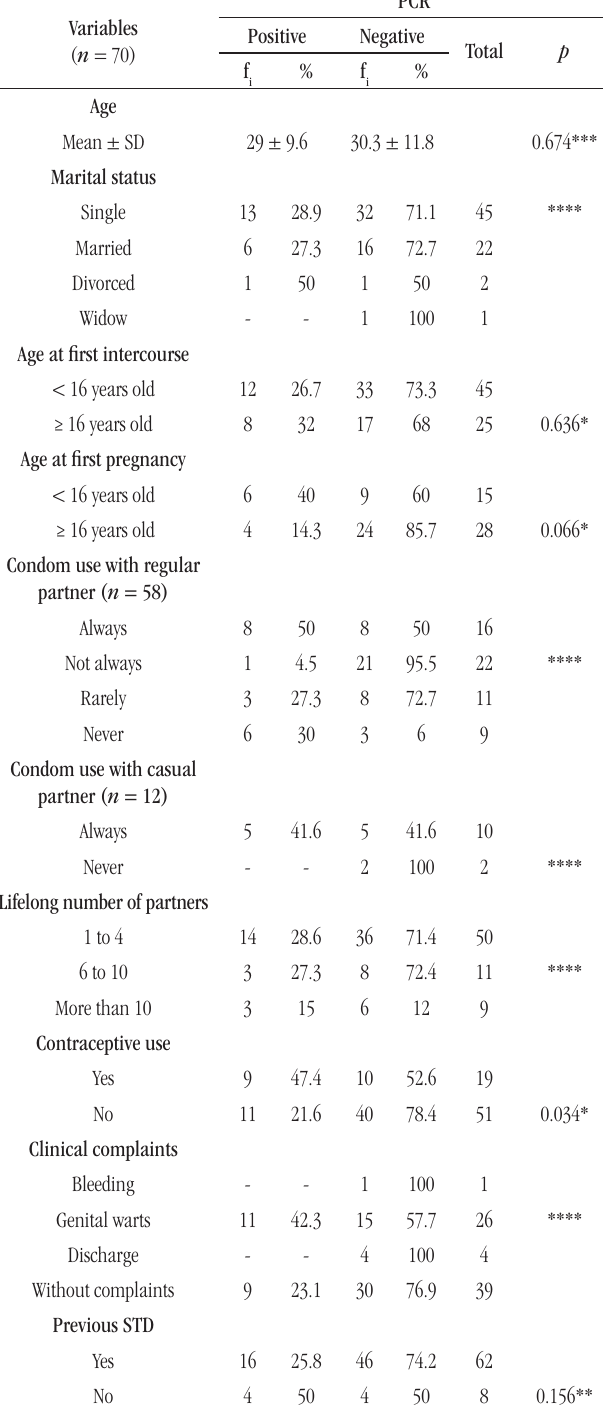
taBLE 4 – Comparison between clinical variables and distribution according to socioeconomic data regarding the outcome of PCR women seen at the clinic for STD at FUAM, Manaus (AM)